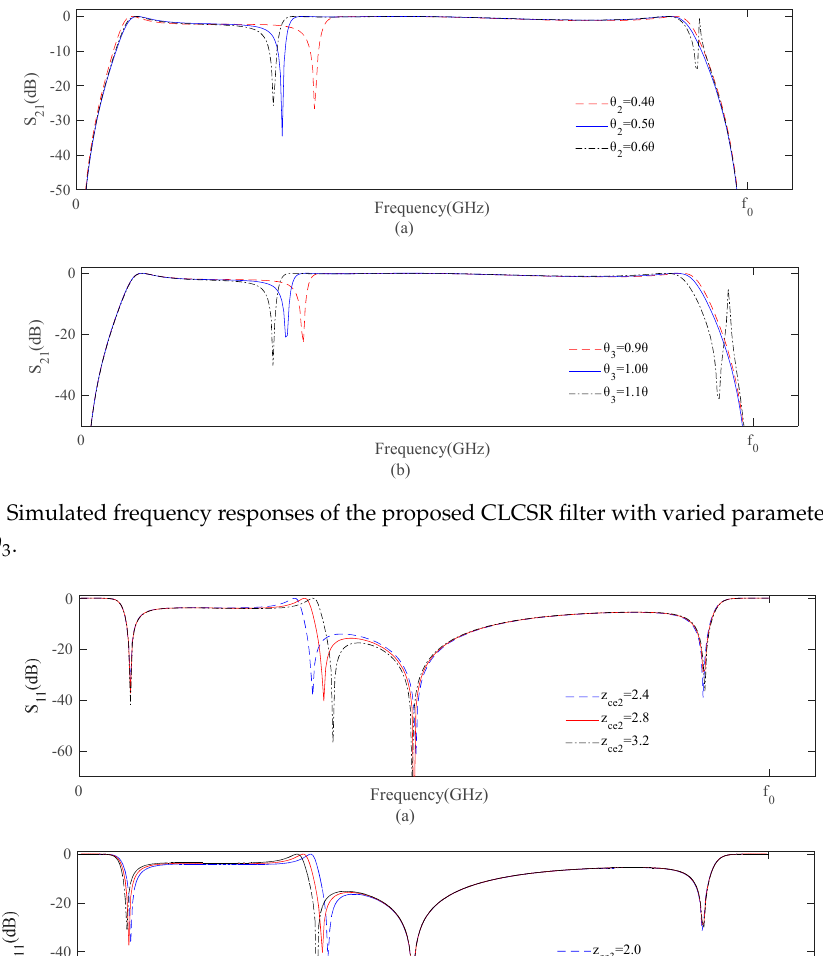
Figure 4. Simulated frequency responses of the proposed CLCSR filter with varied parameters, ( a ) θ θ and ( b ) 3 . 2